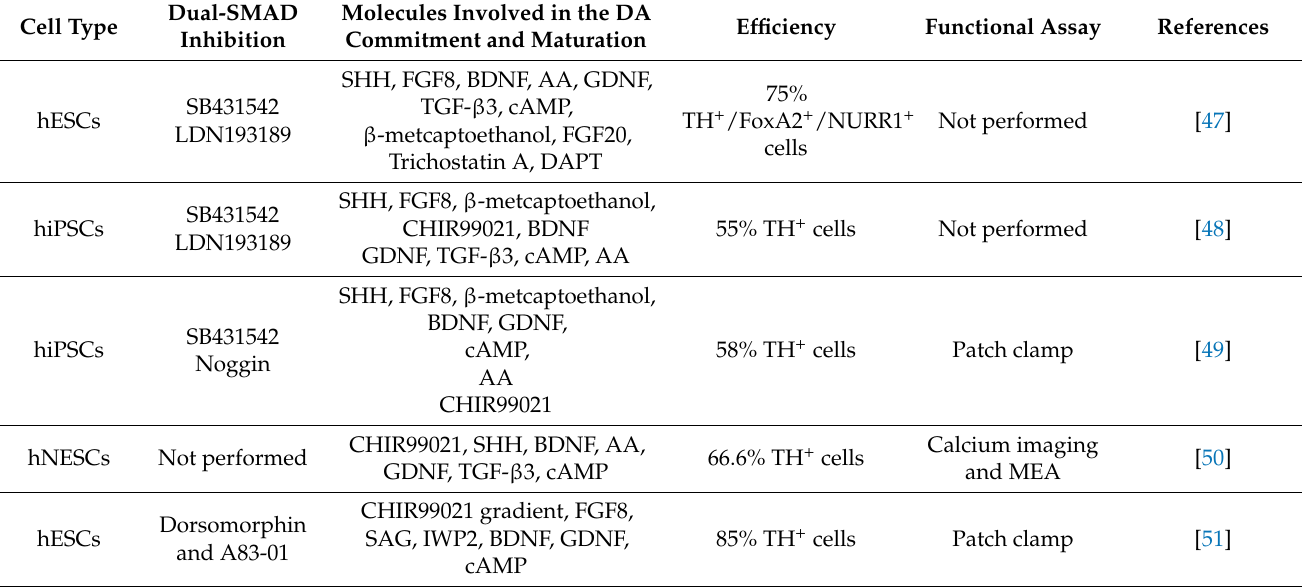
Table 2. Schematic overview of some selected protocol for generation of